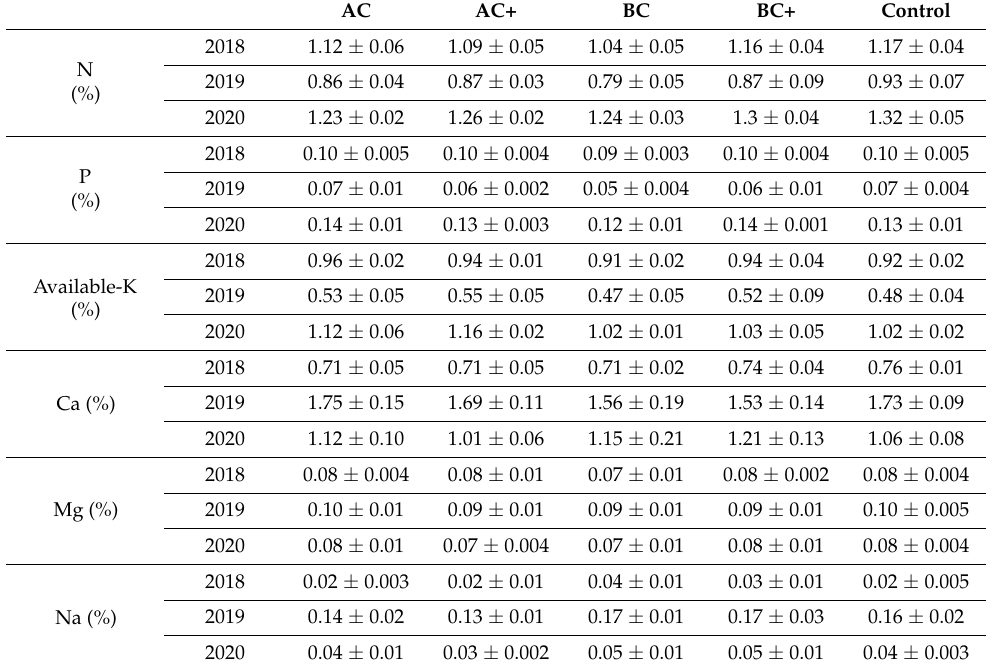
Table 3. Macronutrients in leaf during the 3 years of experiments under different treatments: AC (alperujo compost), AC+ (high dose of alperujo compost), BC (biosolid compost) and BC+ (high dose of biosolid compost). Data are mean values ± standard error of the mean